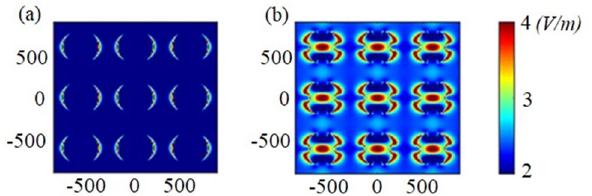
Figure 4. The field profiles for the ( a ) Con-NW and ( b ) QCr-NW designs at wavelength of 908 nm. This image is created by Lumerical 2020a, FDTD Solver Version 8.23.2305, https:// www. lumer ical. com (license number-12802) released to Zewail City of Science and Technology, Giza, Egypt.